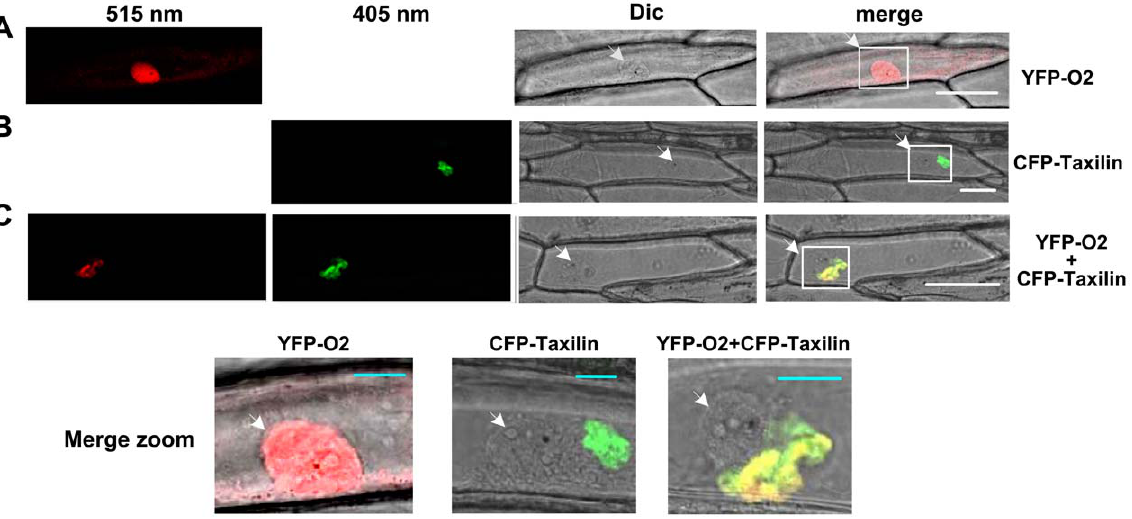
Figure 5. Co-localisation of ZmTaxilin and ZmO2 in onion epidermal cells. ( A ) YFP-O2 was transiently expressed in onion epidermal cells. ( B ) CFP-Taxilin was transiently expressed in onion epidermal cells. ( C ) YFP-O2 and CFP-Taxilin were co-expressed in onion cells. Differential interference contrast mode was used for bright-field microscopy. White Bars represent 100 m m and blue bars represent 20 m m. White arrows showed the localisation of the